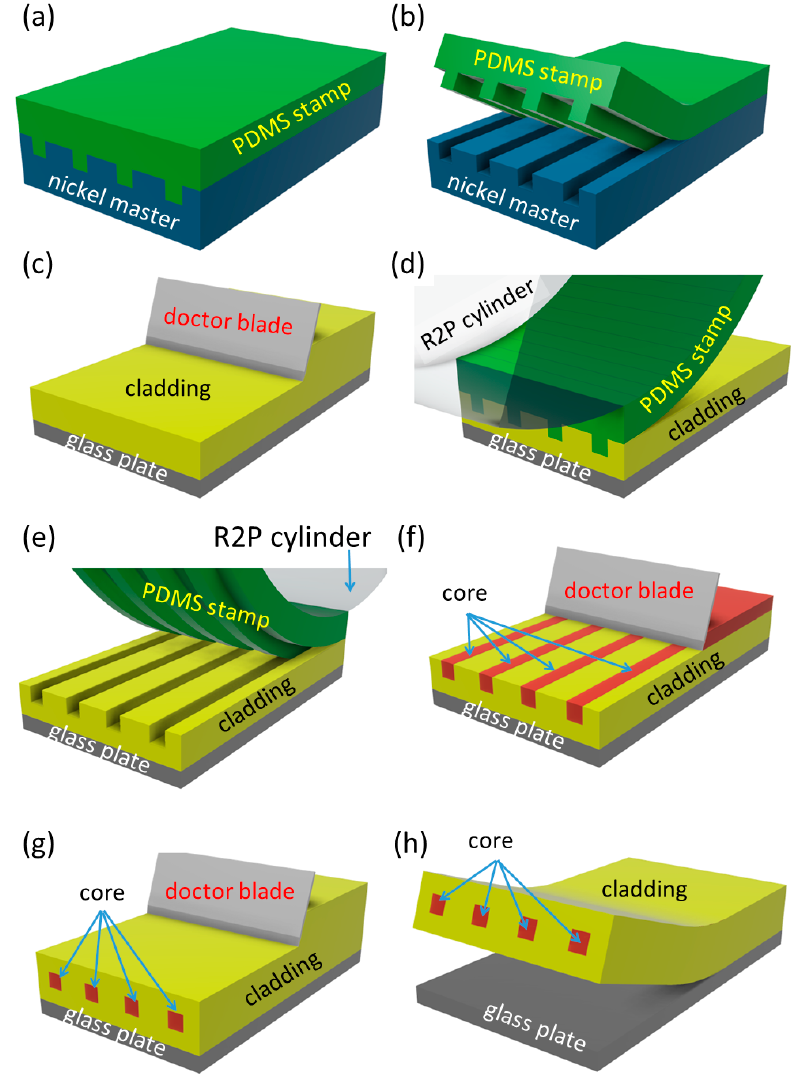
Figure 1. Fabrication process of the multimode optical waveguides using Roll-to-Plate imprinting, ( a ) fabrication PDMS (Sylgard 184) stamp layer, ( b ) separating stamp and Ni-mold, ( c ) fabrication of Varnish 311 UV layer, ( d , e ) fabrication of the U-groove into Varnish 311 UV substrate layer by R2P process, ( f ) fabrication of the OrmoClear ® FX core layer into the U-groove Varnish 311 substrate, ( g ) fabrication of Varnish 311 UV cover cladding layer, ( h ) separating of waveguide structure from the glass